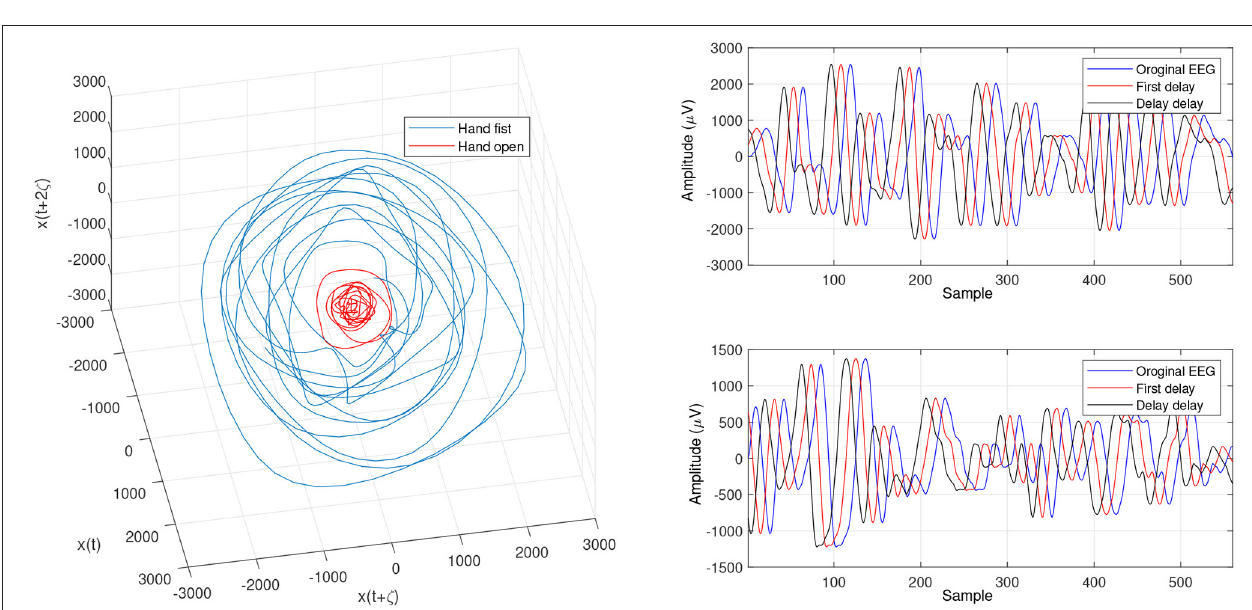
the traditional method and WD algorithms could not find the best lag and embedding dimension for the LLE computations. In order to consider the efficiency of the model in the real- time mode, the trained model was used to control a bionic hand. In the experiment, five subjects participated, and the best obtained accuracy result was obtained by using the LLE with the CTW optimization achieving 65.00% which was